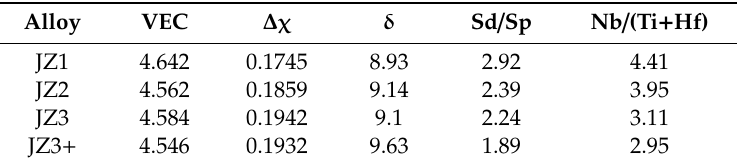
Table 9. The parameters VEC, ∆ χ and δ and the ratios sd / sp and Nb / (Ti + Hf) of the alloys JZ1, JZ2, JZ3 and JZ3 + .